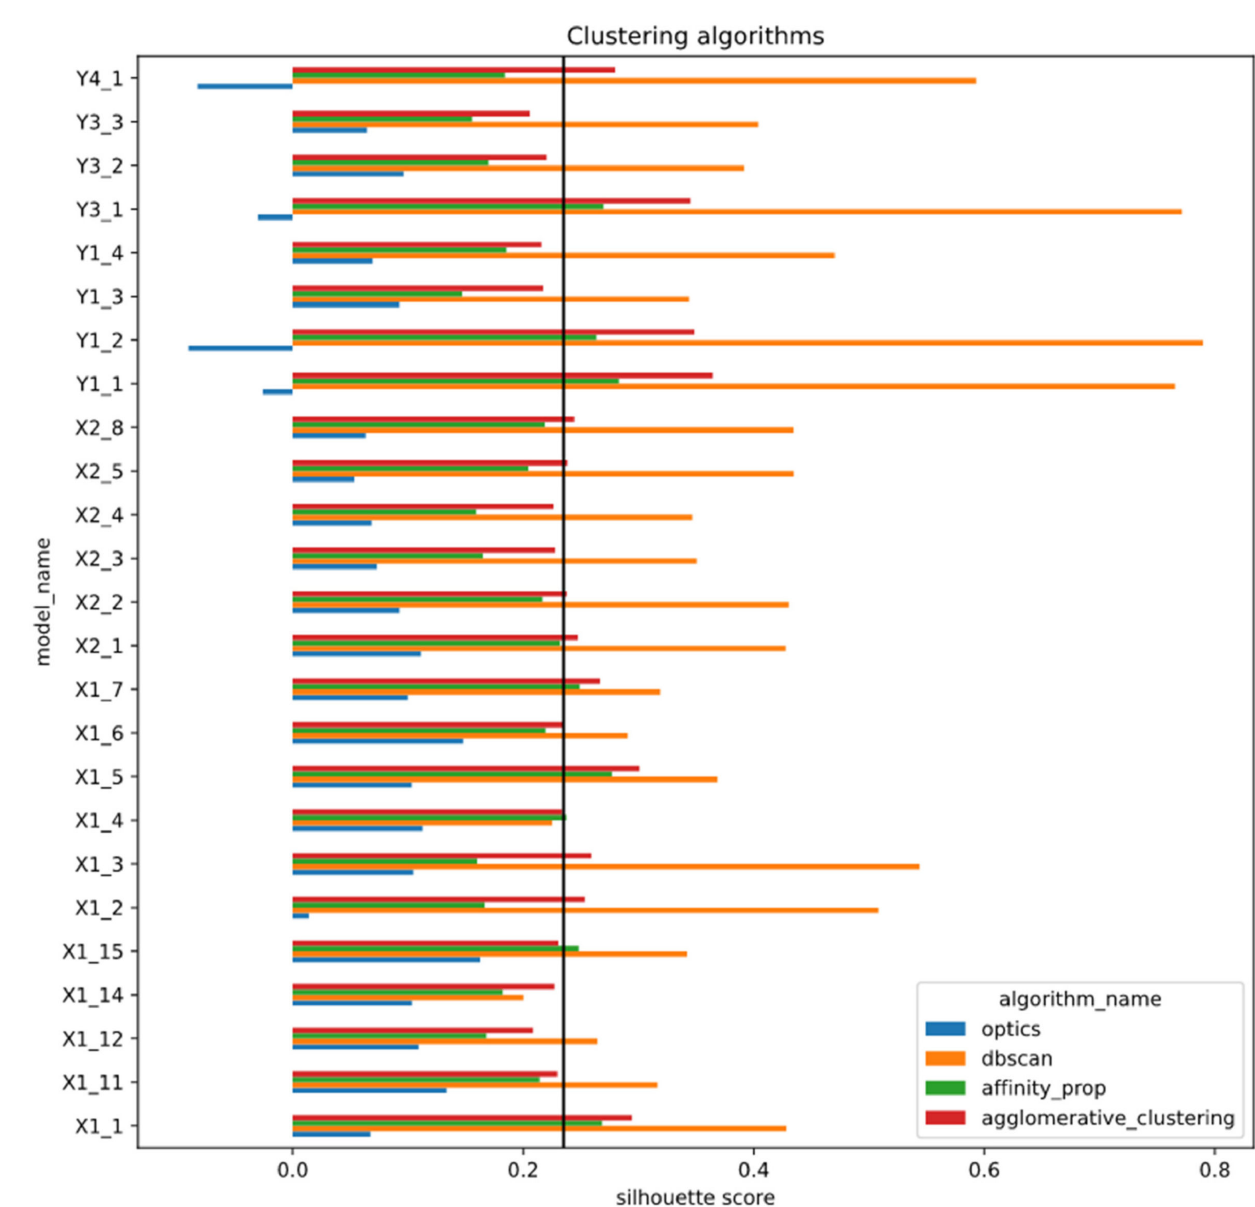
Figure 12. Initial clustering algorithm mean silhouette score result bar plots based on used models and algorithms. The black line indicates the mean silhouette